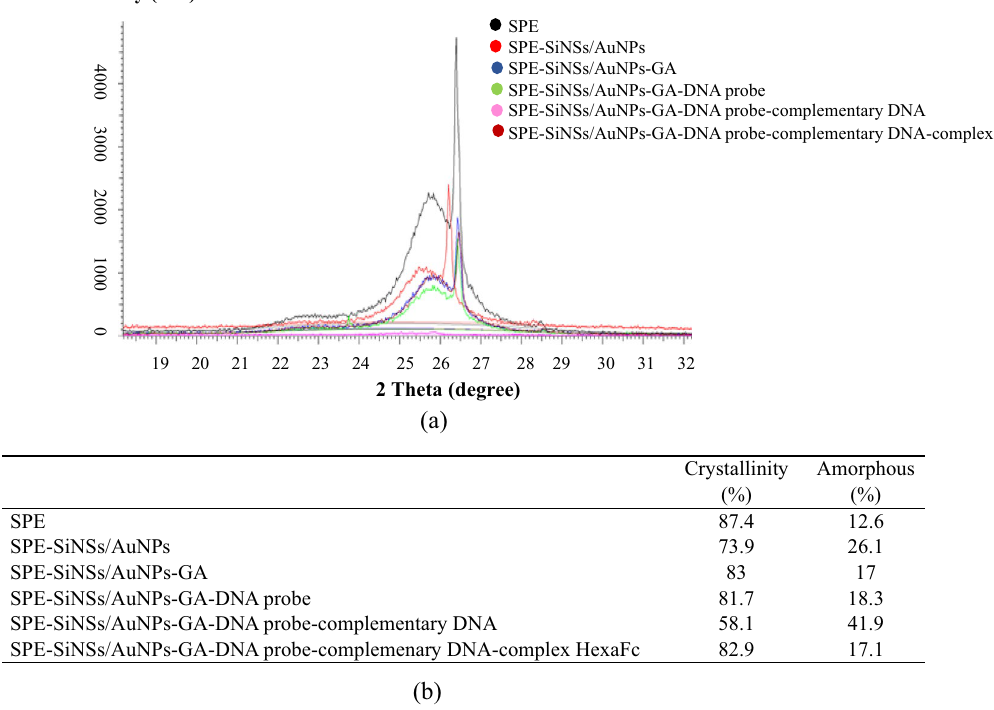
Figure 6. ( a ) XRD diffractogram and ( b ) crystallinity table of layer-by-layer DNA